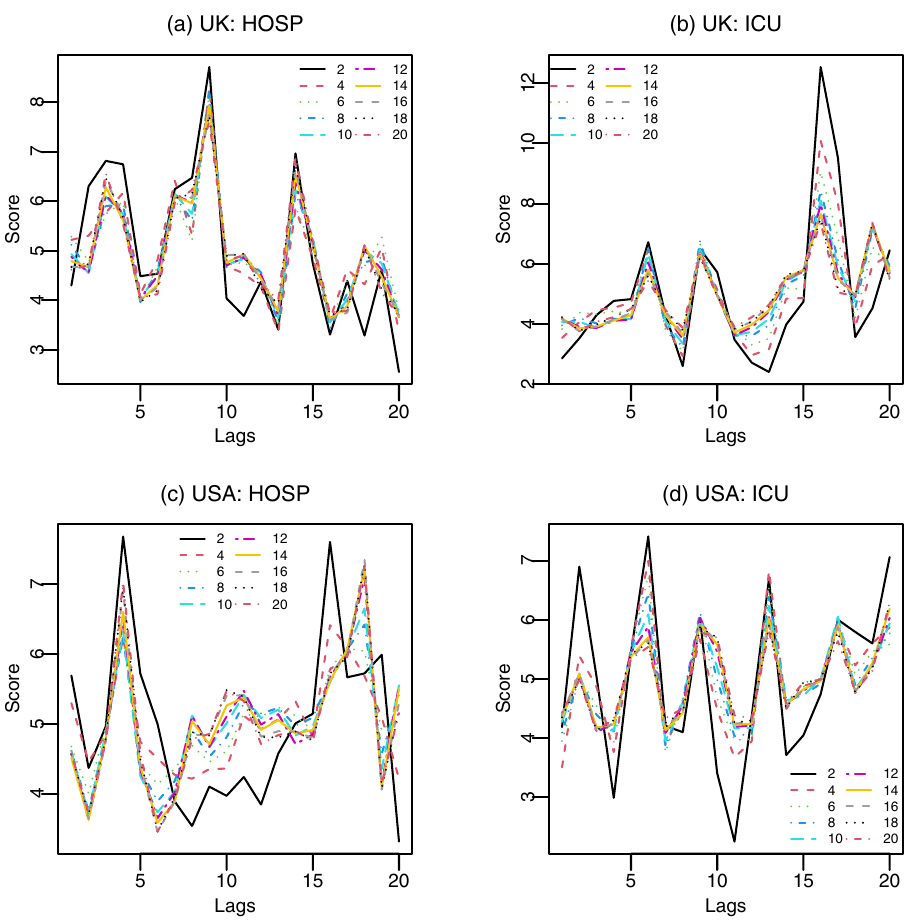
Figure 8. Average feature importance scores computed from 500 replications of NN model with single hidden layer to predict (cid:31) HOSP t and (cid:31) ICU t by using (cid:31) VAC t − k in USA and UK, where k = 1, . . . , 20 . Lines show average scores of lagged features for different number of units ( 2, 4, . . . , 20 ) in hidden